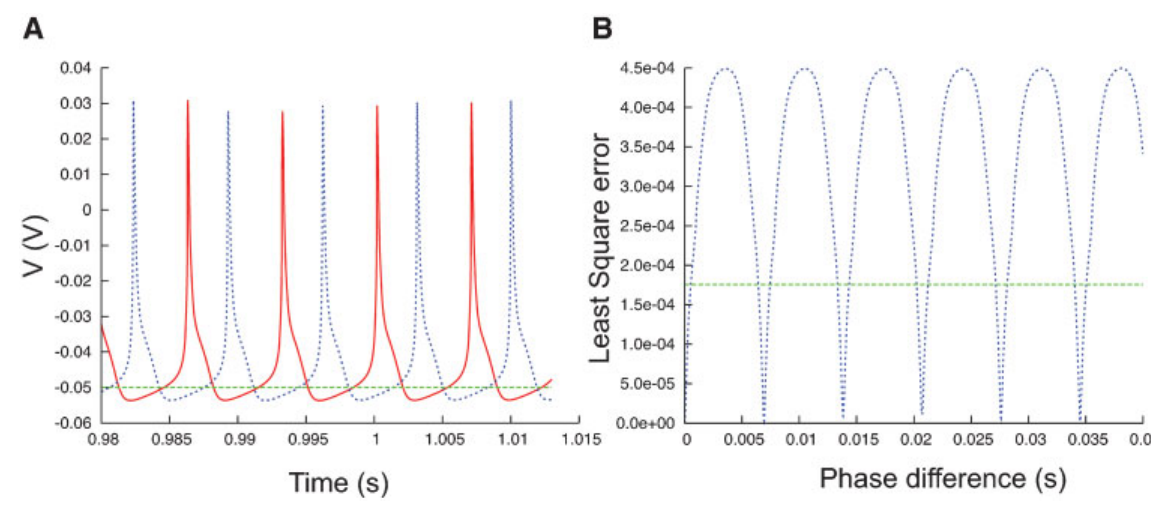
Figure 7. Phase difference between spike trains . ( A ) Plot of a fragment of two spike trains (red and blue) that show a phase difference. On a phase-plane trajectory density plot these two spike trains would show almost the same shape. ( B ) The least square errors (blue trace, Equation 3) between the two spike trains in ( A ) show a maximum when the phase difference is maximal, at that point the values are much higher than the least square errors between the red trace and the flat green trace ( A ).